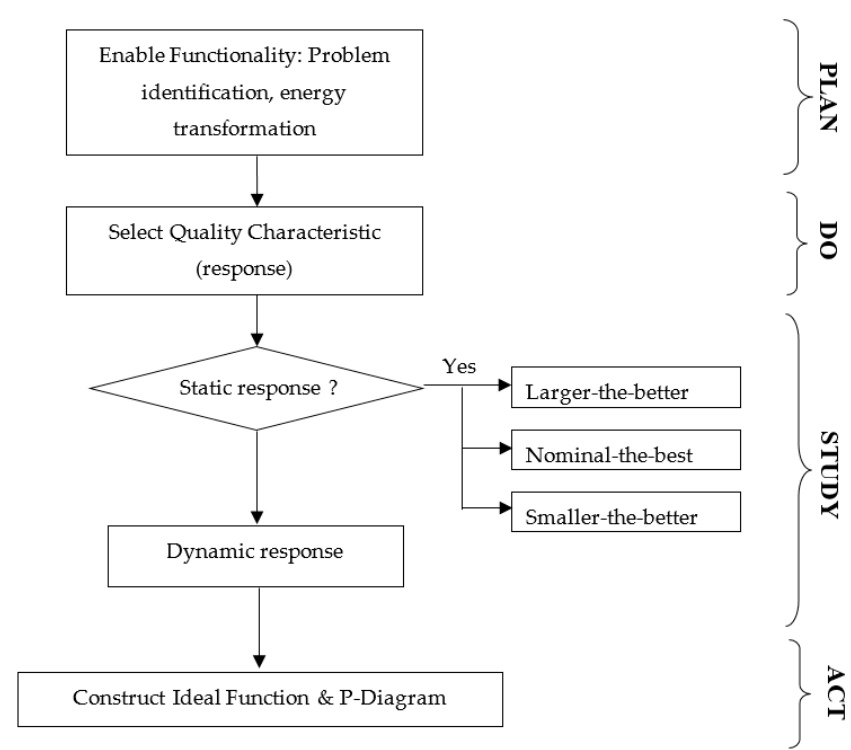
Figure 12. Function (F) sub-system of F-N-C-O.